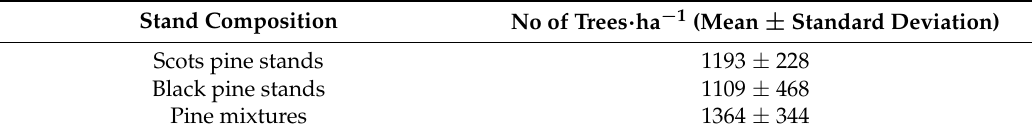
Table 3. The current density of plantations with the age of more than 40 years.